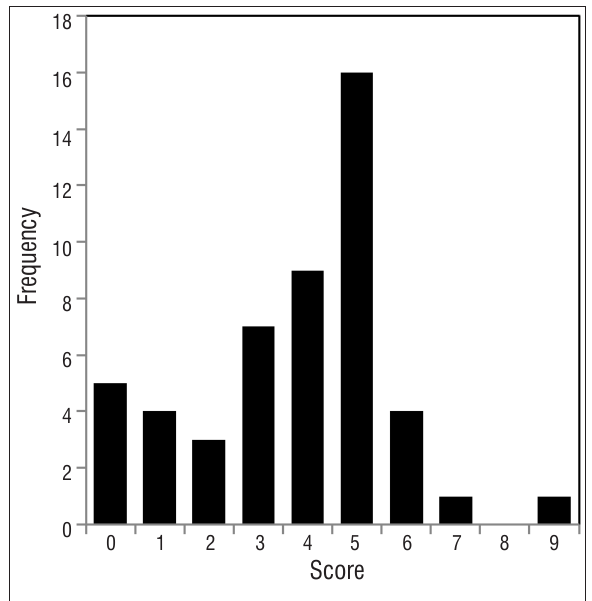
Figure 6: Histogram of frequency of scores according to the classification scheme in which zero is least impacted and nine is most impacted (see text for significance of